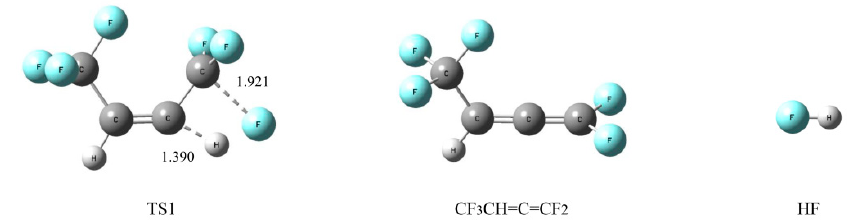
Figure 12. Geometric optimization of transition states, intermediates and radicals of intramolecular elimination reaction for HFO-1336mzz(Z). C, H and F atoms are represented with black, gray and blue balls, respectively.